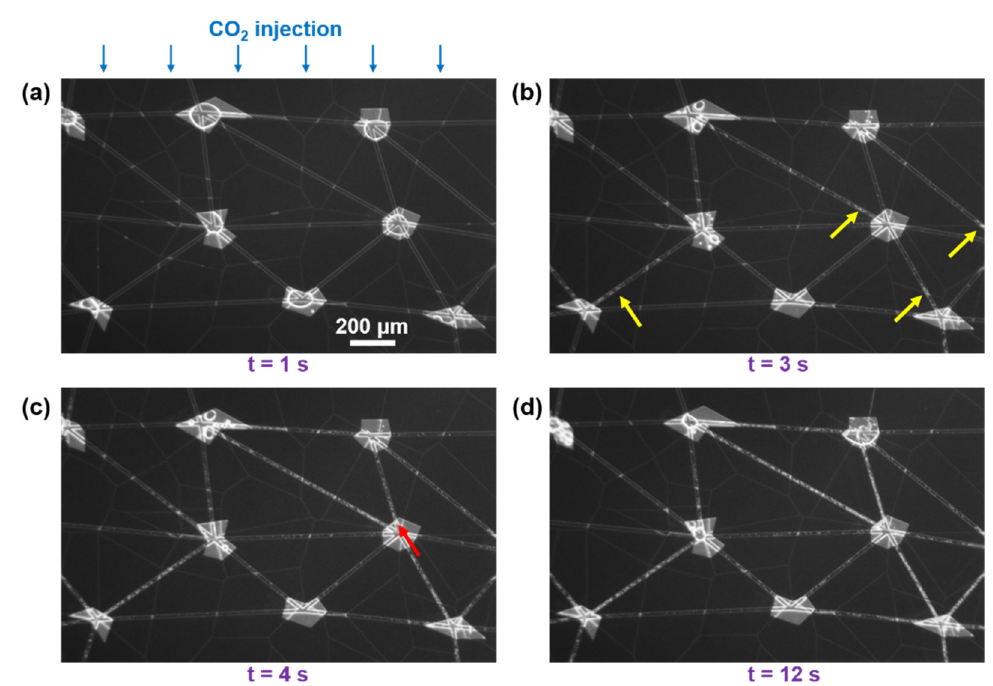
Figure 2. Salt precipitation in the 500-nm deep network and 5- µ m deep pores during CO 2 injection at constant pressure (1 MPa). ( a – d ) are recorded images of salt precipitation at approximately 1, 3, 4 and 12 s. The white particles are the precipitated salt contents. The yellow and red arrows indicate salt precipitations in the 500-nm deep network and 5- μ m deep pores.